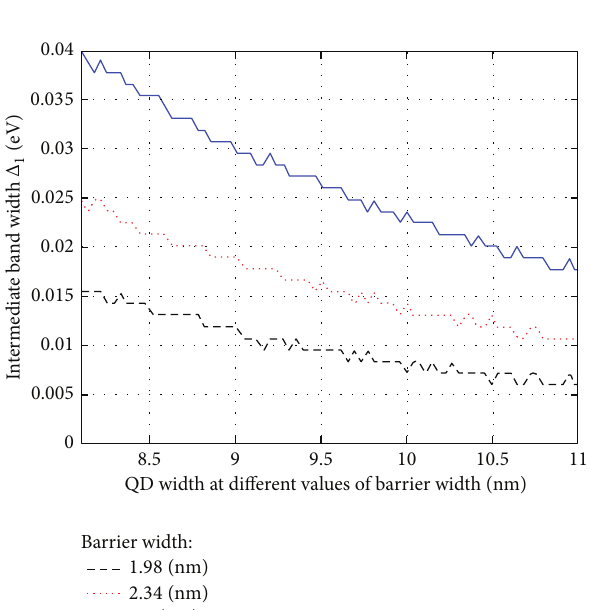
Figure 8: Change width of intermediate band ( Δ 1 ) with change QD width for the second allowable range at three different values of barrier